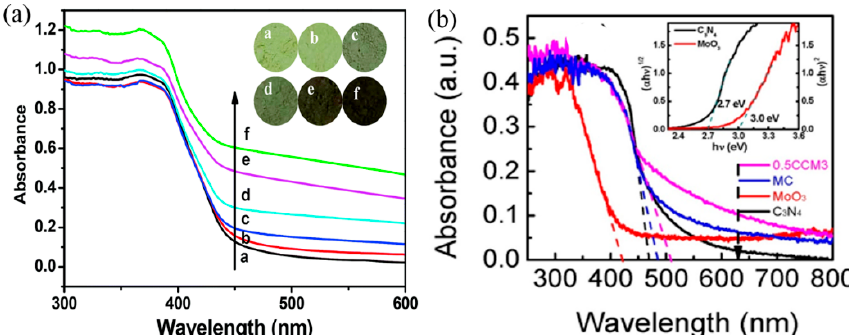
Figure 4. UV-vis diffuse reflectance absorbance spectra of ( a ) a–f: g-C 3 N 4 , CDs/g-C 3 N 4 (1 wt.%), CDs/g-C 3 N 4 (5 wt.%), CDs/g-C 3 N 4 (10 wt.%), CDs/g-C 3 N 4 (50 wt.%) and CDs/g-C 3 N 4 (100 wt.%), respectively; ( b ) MoO 3 , g-C 3 N 4 , CM3 and 0.5CCM3 (reproduced with permission from [92,100]. Copyright Royal Society of Chemistry, 2017; Elsevier, 2018; respectively).